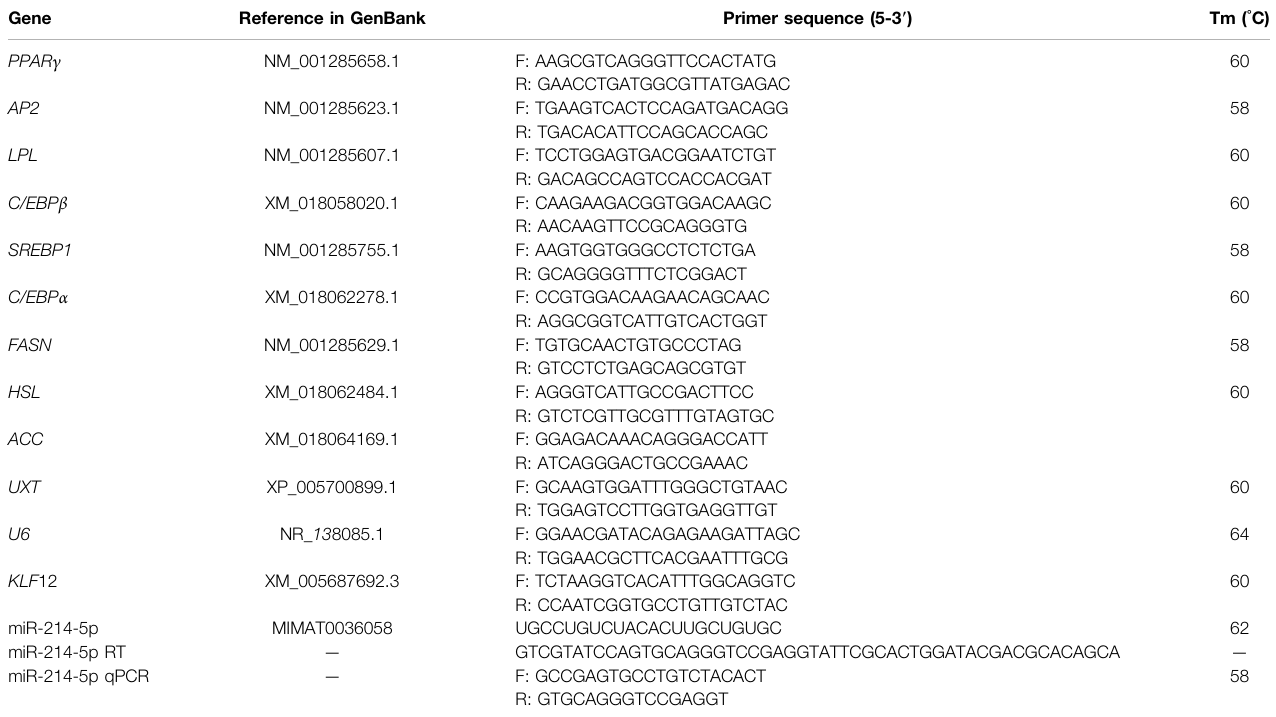
TABLE 2 | Sequences of information of